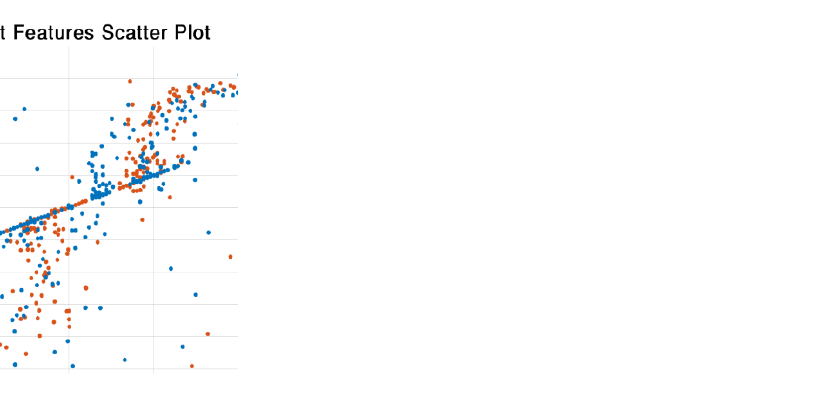
Figure 5. Scatter plot of COVID and non-COVID features (orange dots show COVID and blue dots show non-COVID features).